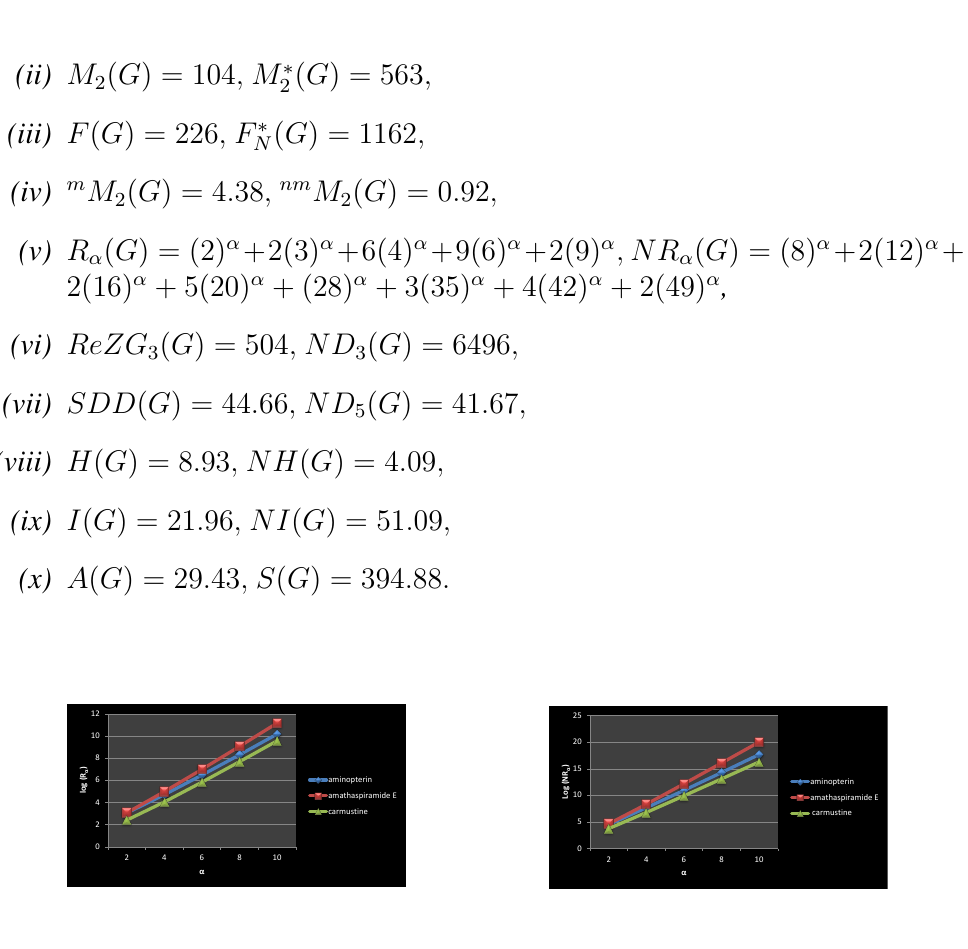
Figure 19: Plotting of R